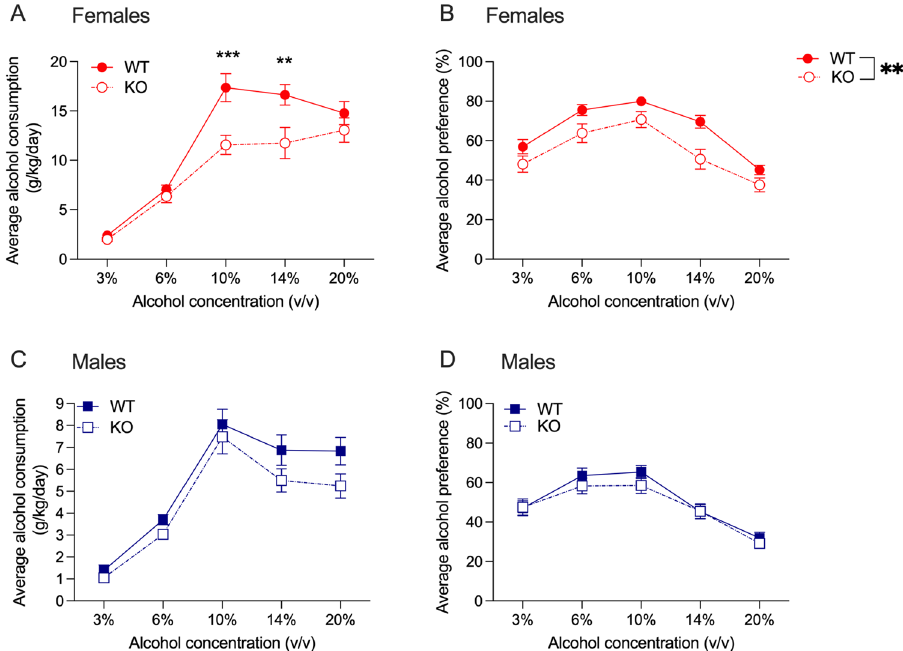
Figure 1. Alcohol consumption and preference in Hgfac WT and KO mice. ( A ) Female Hgfac KO mice had significantly reduced alcohol consumption at the 10% and 14% alcohol concentrations. Sidak’s multiple comparisons testing ** P < 0.01 and *** P < 0.001 compared with WT mice. ( B ) There was a reduction in overall alcohol preference in female Hgfac KO mice compared with WT mice. ** P = 0.003 for main effect of genotype. There was no difference between ( C ) alcohol consumption and (D) alcohol preference between the male Hgfac KO and WT littermates. Data are presented as mean ± SEM, n = 28–39 female mice per genotype, n = 36–38 male mice per